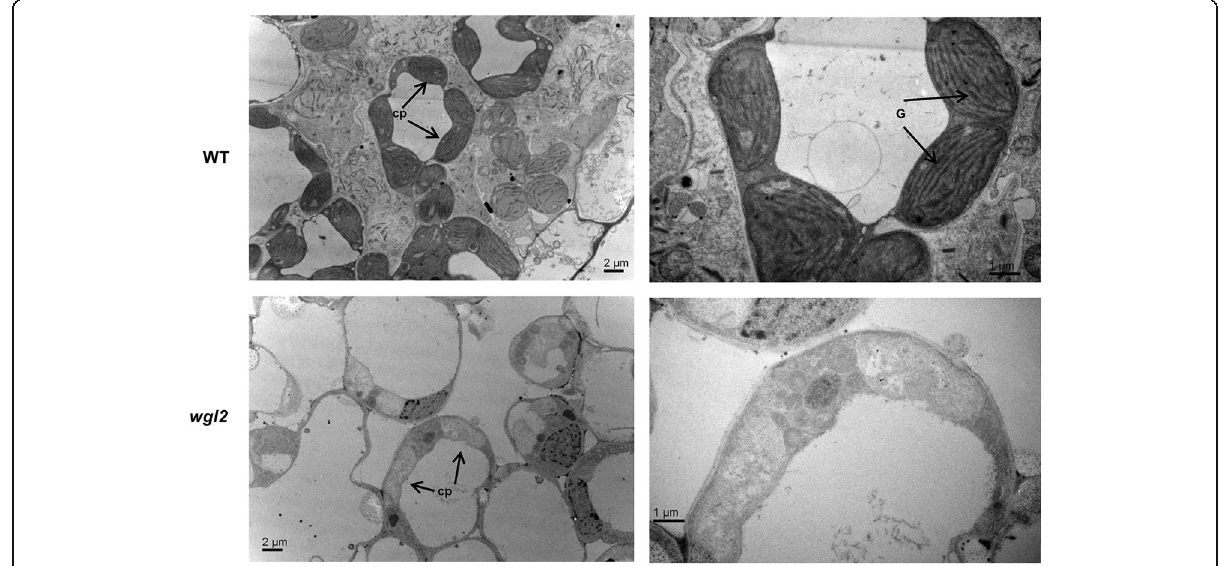
Fig. 2 Microstructures of wild type (WT) and wgl2 white seedlings chloroplasts viewed with transmission electron